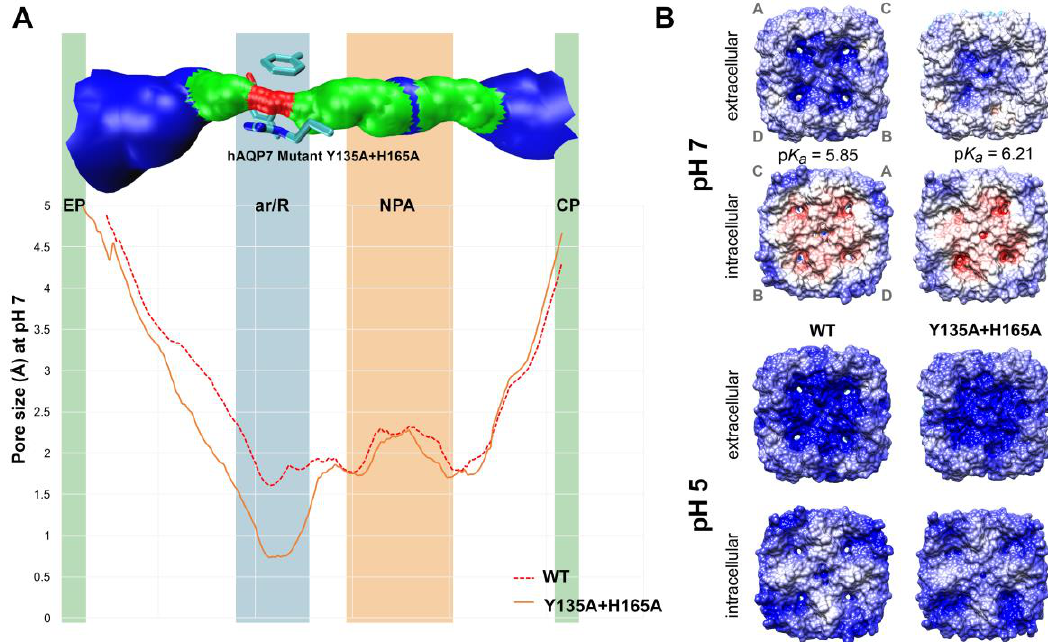
Figure 6. Pore size and protein surface electrostatic charges. ( A ) Pore size of human AQP7-WT and double mutant Y135A+H165A, analyzed using HOLE [53]. Top channel surface represents the pore size of hAQP7 mutant, Y135A+H165A (based on VDW radii): Red = smaller than single H 2 O, green = single H 2 O, blue = larger than single H 2 O. Figure generated by HOLE [53] and VMD [63]. ( B ) Electrostatic surfaces of hAQP7-WT and mutant Y135A+H165A, at pH 5.0 and 7.0, with the following color code: Positively charged = blue, negatively charged = red, neutral = white. Top views of both intra and extracellular sides, with the p K a of each protein indicated in the figure. Surfaces were generated using the Adaptive Poisson-Boltzmann Solver (APBS) [48] plugin in Chimera [49]. Monomers labeled A–D are shown in grey to indicate their position in each view.